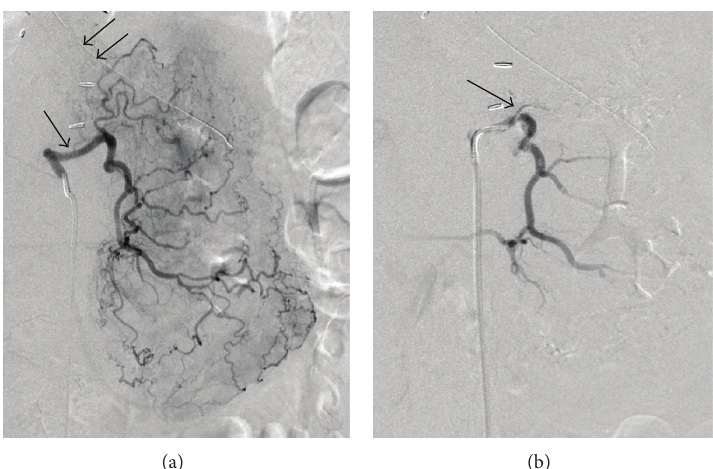
Figure 1: 72-year-old male was found to have bleeding at the gastric fundus on endoscopy. (a) Digital subtraction angiography (DSA) of the LGA (black arrow) demonstrated no evidence of contrast extravasation to suggest bleeding. A nasogastric tube is also seen (double black arrows). (b) DSA performed after gelfoam embolization of the LGA revealed a significant decrease in the opacification of the arterial branches in the fundus (black arrow).